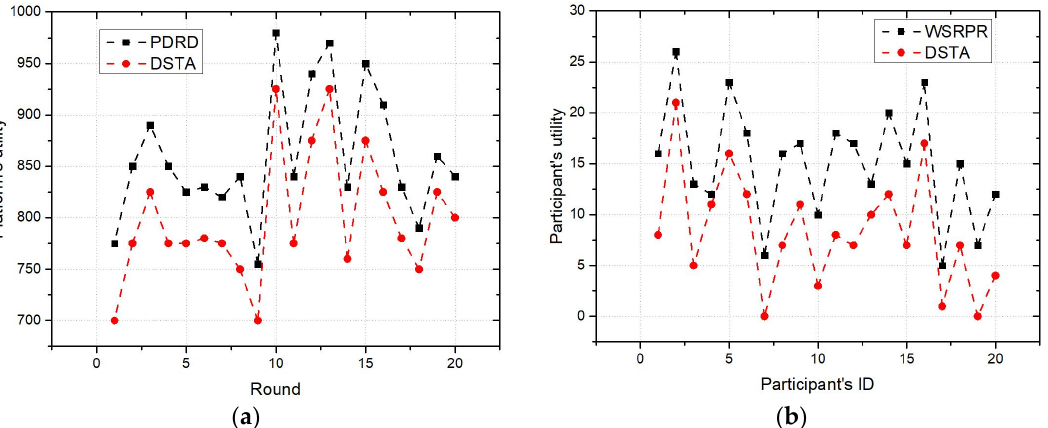
Figure 8. ( a ) Comparison of platform’s utility, ( b ) comparison of participant utility.